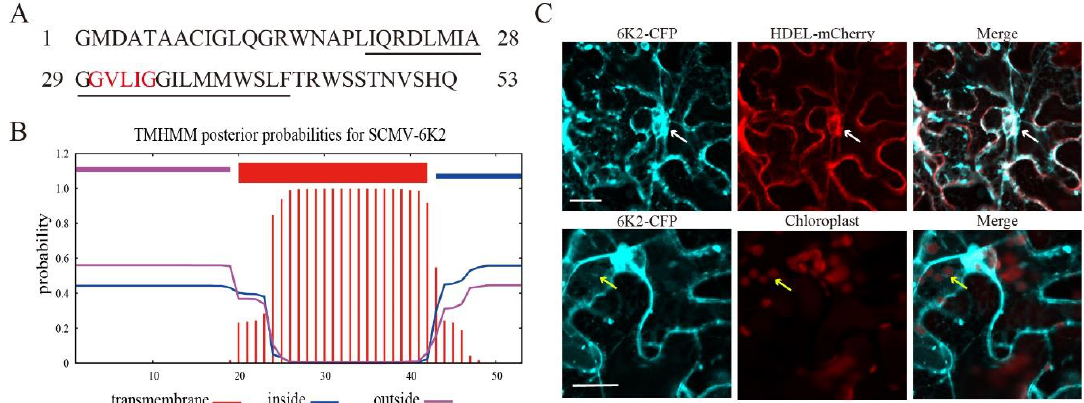
Figure 1. Subcellular localization of Sugarcane mosaic virus (SCMV)-6K2. ( A ) The schematic diagram of the amino acids of the SCMV-6K2 protein. GXXXG motif (‘X’ being any amino acid) was highlighted by the red color. The predicted transmembrane domain (TMD) was marked by an underline. ( B ) Prediction of SCMV-6K2 TMD by TMHMM. The horizontal axis indicates the amino acid position. ( C ) Subcellular localization of 6K2-CFP in the leaves epidermal cells of N. benthamiana by 48-h post agroinfiltration. White arrows point to endoplasmic reticulum (ER), yellow arrows point to chloroplast. Scale bars, 25 μm.